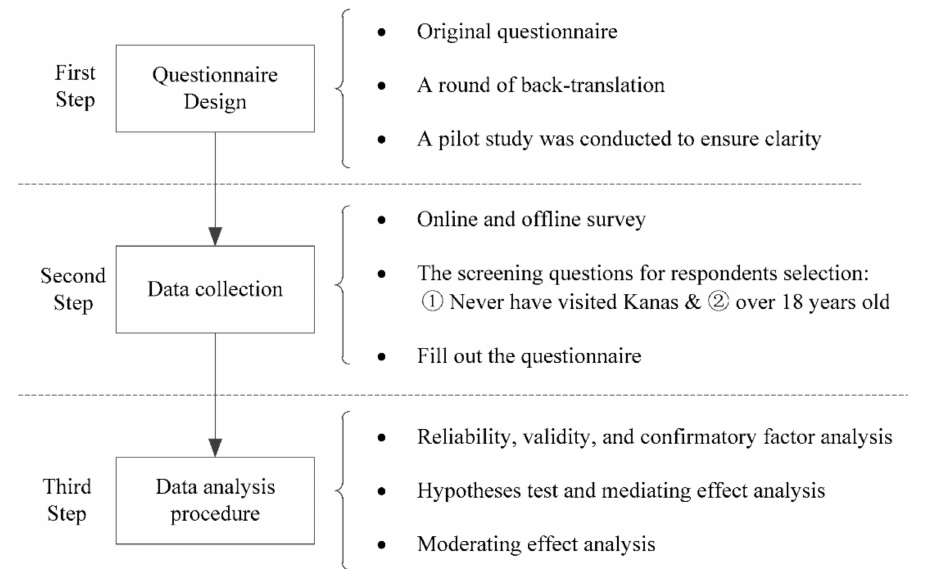
Figure 3. Questionnaire design, data collection, and analysis